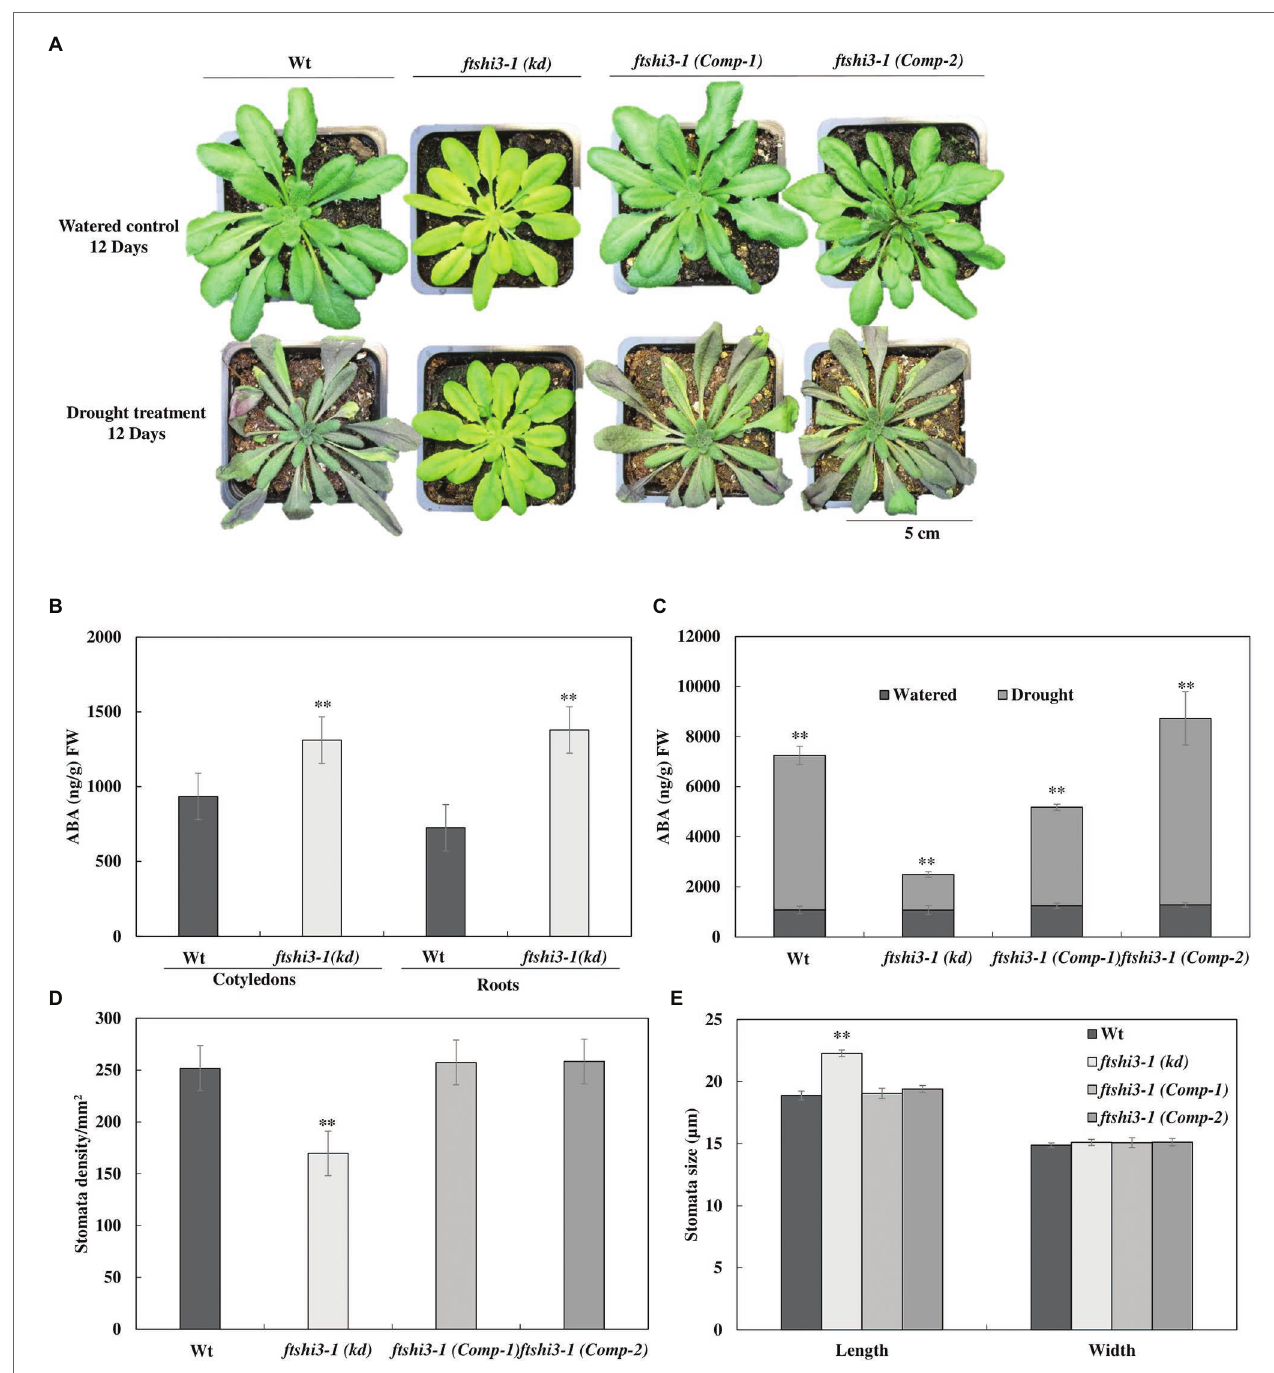
FIGURE 4 | (A) Representative phenotypes of 6-week-old Wt, ftshi3-1(kd) , and ftshi3-1 (Comp-1 and Comp-2) plant after exposure to drought stress for 12 days. (B) Quantification of abscisic acid (ABA; ng/g) FW in 10-day-old seedlings of Wt and ftshi3-1(kd) grown in a growth chamber at LD and 22 ° C. Asterisks indicate a significant difference ( ** p < 0.05, Student’s t test, n = 3). Error bars represent the SE. (C) Quantification of ABA (ng/g) FW in leaves of watered and drought-stressed plants. Asterisks indicate the significant difference of ABA (ng/gm) content in watered and drought conditions ( ** p < 0.05, Student’s t test, n = 4). (D) Measurements of the stomatal density and (E) the stomatal size of Wt, ftshi3-1(kd) , and ftshi3-1 (Comp-1 and Comp-2) . Asterisks indicate a significant difference. Error bars represent the